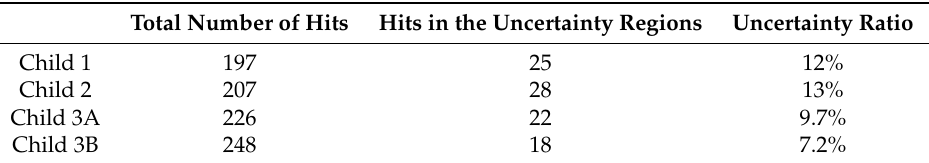
Table 6. Estimation of gaze hits in uncertainty